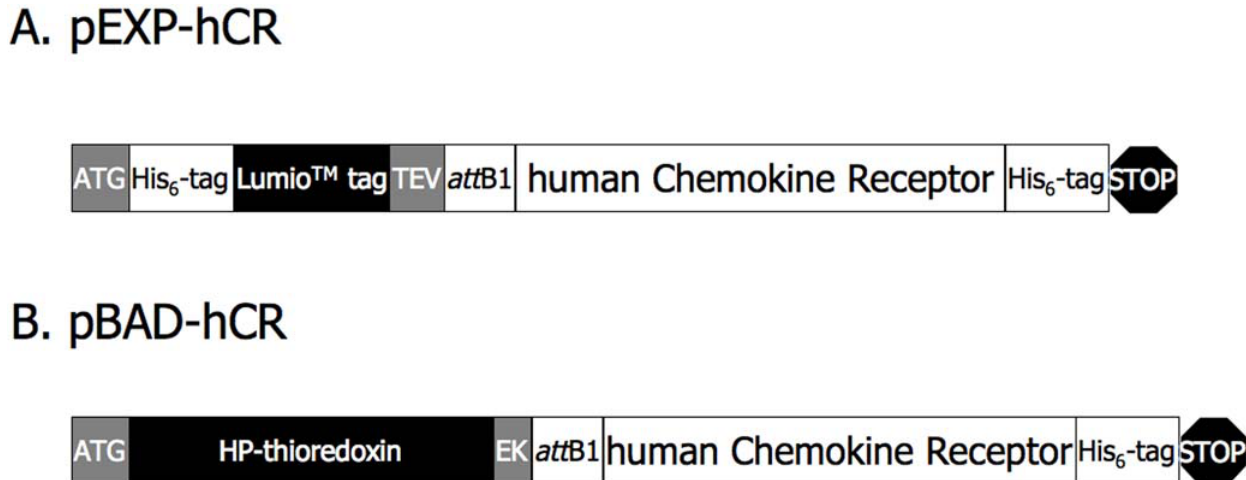
Figure 2. Schematic illustrations of 4 hCRs expressed as fusion proteins. In each synthetic hCR gene with a His 6 -tag was inserted at the C- terminus for expression, detection and protein purification, and each gene was cloned into pEXP3-DEST and pBAD-DEST49 vectors, respectively. A) Schematic representation of hCR cloned into pEXP3-DEST vector (simply pEXP-hCR). The translation start codon (ATG) followed by His 6 -tag, Lumio TM –tag and TEV (TEV protease recognition site) are present in the vector pEXP3-DEST and fused at the N-terminus of hCR following the insertion of the C-terminally His 6 -tagged hCR at the att B1 site by the Gateway site-specific recombination reaction. B) Schematic representation of hCR cloned into pBAD-DEST49 vector (pBAD-hCR). Analogous to the pEXP-hCR vector, the ATG, HP-thioredoxin (Trx) and EK (Enterokinase recognition site) are present in the pBAD-DEST49 vector and fused at the att B1 site to the N-terminus of hCR, following Gateway protocols.